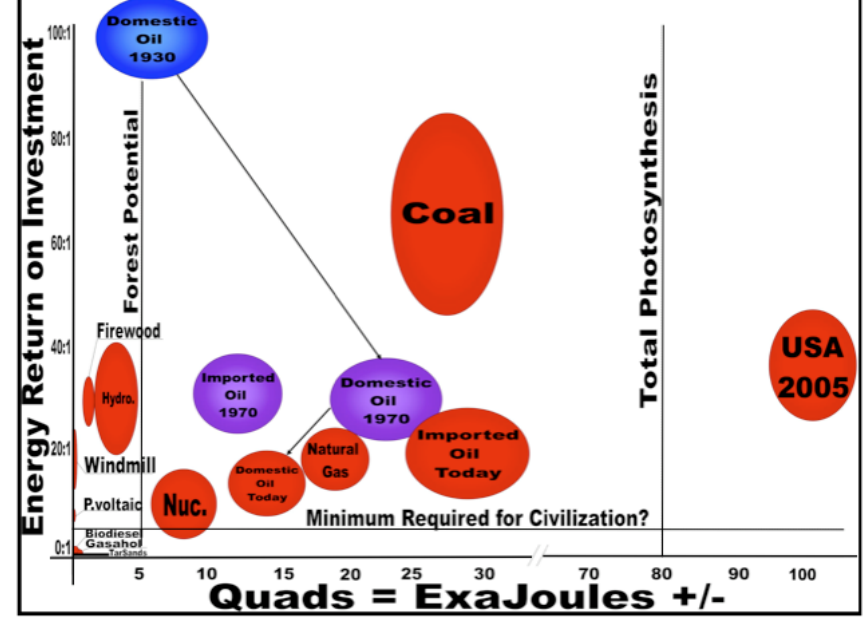
Figure 2. “Balloon graph” representing quality (EROI – Y axis) and quantity (X axis) of the United States economy for various fuels at various times. Arrows connect fuels from various times (i.e. domestic oil in 1930, 1970, 2005 – “today”), and the size of the “balloon” represents part of the uncertainty associated with EROI estimates, i.e. larger “balloons” represent more uncertainty. The horizontal line indicates that there is some minimum EROI that is needed to make society work, and the vertical line to the left indicates one estimate of maximum forestry potential and the vertical line to the right is David Pimentel’s earlier estimate of total photosynthesis in the United States (Source: US EIA, Cutler Cleveland and C. Hall’s own EROI work in preparation). (Reprinted with minor changes from